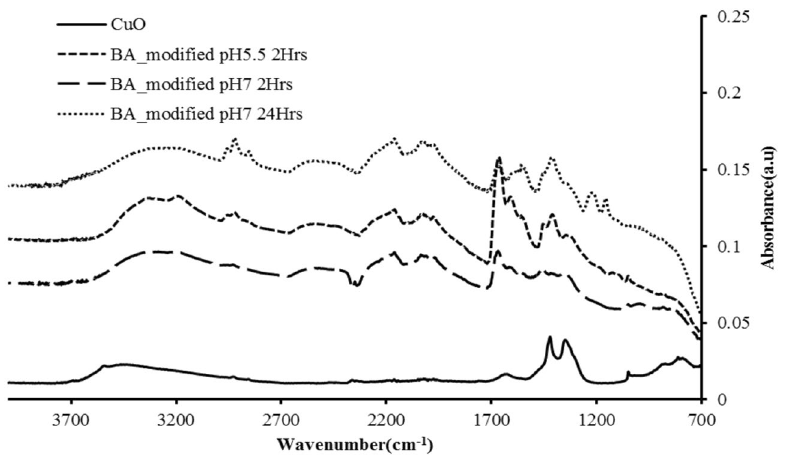
Figure 5. Modified CuO nanoparticles by using butyric acid as the reagent; ( a ) CuO nanoparticle original particles; ( b ) CuO nanoparticle modified using BA (Reaction time 2 h and pH 5.5); ( c ) CuO nanoparticle modified using BA (Reaction time 2 h and pH 7); ( d ) CuO nanoparticle modified using BA (Reaction time 24 h and pH